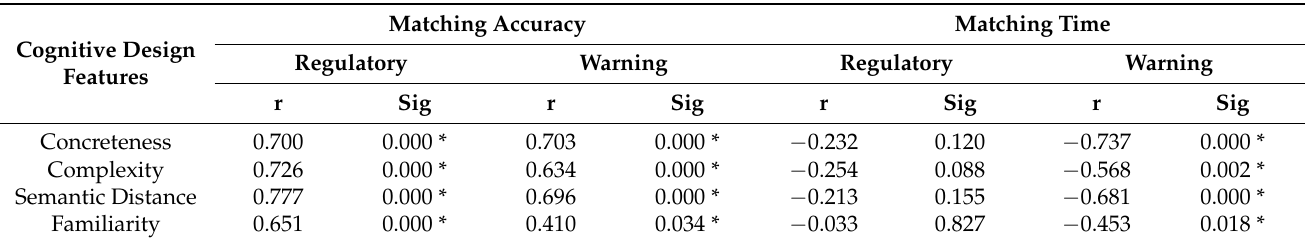
Table 9. Pearson Correlation for Cognitive Design Features and Traffic Sign Types.